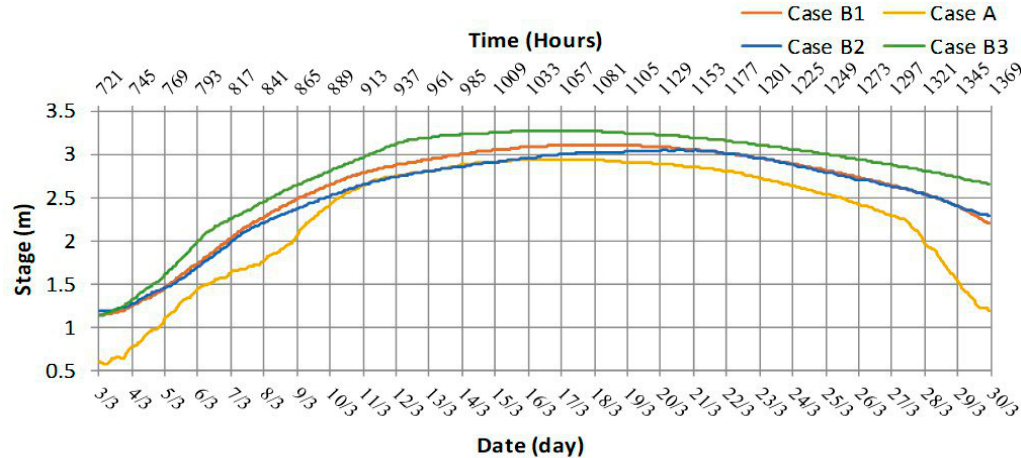
Figure 18. The stage in section no. 65 during the period of wave occurrence. Hydrology 2019 , 6 , x